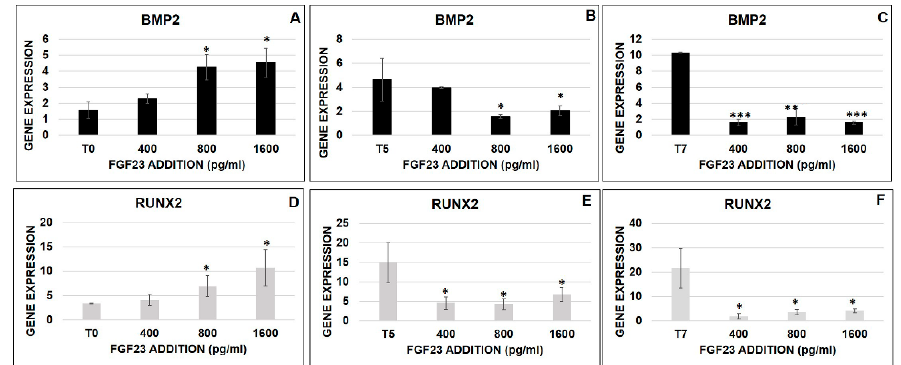
Figure 12. qRT-PCR of BMP2 ( A , B , C ) and RUNX2 ( D , E , F ) 24 h after 400, 800, 1600 pg/mL of FGF23 addition at T0, T5, and T7 during the osteo-induction ( A ). Asterisks indicate significant differences versus M2-10B4 T0, T5, and T7 without induction: * p < 0.05, ** p < 0.01, *** p < 0.001.